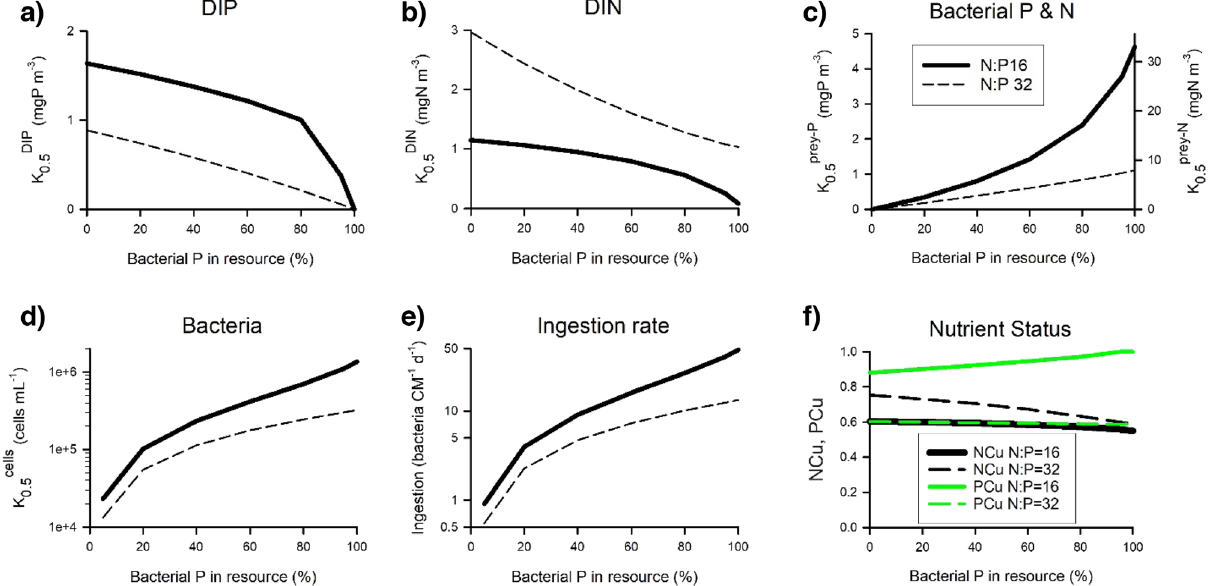
Figure 4. Relationships between the proportion of nutrients provided via phagotrophy and emergent half saturation values for resources supplied as inorganics (DIP, DIN) and/or as bacteria. These are outputs from the chemostat simulations run at a dilution rate to enable the constitutive mixoplankton (CM) to grow at half the maximum growth rate (i.e., as required to derive values of K 0.5 ). Data are shown for a CM of 5 µm ESD, growing with a total resource abundance of 70 mgN m −3 , associated with a total mole N:P of 16 or 32, with the indicated % of the P allocated as bacterial P (x-axis). K 0.5 values for DIP, DIN and bacteria are shown in panels ( a ), ( b ) and ( c ) respectively; the bacterial C:N:P was fixed, hence the same plot lines are read for K 0.5 prey-P and K 0.5 prey-N on different y-axes in ( c ). Panel ( d ) shows K 0.5 for bacteria cell numbers, with the ingestion rates in panel ( e ). Panel ( f ) shows the emergent N and P nutrient status of the mixoplankton, where 1 is replete and 0 is starved; only at resource N:P = 32 was P-status (PCu) lower than that for N (NCu). See Table S1 for stoichiometric values and Fig. S6 for the proportions of C, N and P acquired from in ingestion rates (Fig. 4e) reflect the interplay in photo-phago-physiology. Values for K 0.5 DIP (Fig. 4a), K 0.5 DIN (Fig. 4b), K 0.5 prey-P & K 0.5 prey-N (Fig. 4c), and, K 0.5 cells for prey (Fig. 4d) differed under resource regimes of N:P = 16 versus N:P = 32. P was more limiting than was N with N:P = 32, but this limitation was not so pronounced with higher allocations of resource P within bacteria (Fig. 4f). The proportion of P from bacteria that contributed to CM growth closely tracked the proportion supplied under both N:P resource regimes (Fig. S6). The contribution of prey biomass to mixoplankton needs was much lower for N than for P (< 50% of the P supply), and lower again in terms of C (< 20% of the P supply); these differences were greater for N:P = 32 (Fig. S6). The effect of growing mixoplankton at different photon flux densities (PFD) upon the balance of photo- versus phago- trophy is shown in Fig. 5 (cf. Fig. 4). The significance of feeding increased at lower PFD (provision of P from predation approached 100%), with significant contributions to growth at ingestions of even just a few bacteria per day for growth rates of around 0.2 d −1 . At lower PFD, ingestion rates were higher, supporting greater contributions of bacterial C,N,P to CM biomass. These higher ingestion rates at low PFD required higher prey abundances (Fig. S7). Concurrently, with the decline in the relative importance of phototrophy at those lower PFDs, higher residual DIP was present as more P was acquired via phagotrophy. Different N:P resource levels at different PFD also affected the N and P status of the mixoplankton (Fig. S8); the N:P = 32 series had a greater level of P-stress in the mixoplankton, but for both N:P scenarios, growth at lower PFD raised the N and P status because the cells became increasingly C-limited. The simulations shown in Figs. 4 and 5 used bacterial prey. Comparisons between rates of ingestion of bacteria or cyanobacteria required to support a given rate of CM growth in the N:P = 16 resource regime are shown in Fig. 6; at most these amounted to 1 ingestion per CM per hour to make significant contributions to growth rates of up to 0.6 d −1 . Contributions from feeding for the supply of C were low in all instances compared to contribu- tions of N and P, noting these simulations were undertaken in a light-saturating system with 20% of resource-P supplied as prey-P (cf. Fig. 5). Ingestion rates of only 1 to 6 prey d −1 supported 20% of P needs at growth rates of up to ca. 0.3 d −1 . The relative contributions from feeding declined at higher growth rates because encounter rates with prey became limiting relative to the increasing availability of inorganic nutrients (consistent with chemostat theory, and, also consistent with differences between the K 0.5DIN and K 0.5prey-N shown in Fig. 4). Prey abundances of the order of 10 4 mL −1 were required to support growth rates of < 0.1 d −1 , ranging up to ca. 5 × 10 5 mL −1 of the non-motile cyanobacteria prey (‘Cya’ in Fig. S9) to support a CM growth rate of 0.6 d −1 . Ingestion of cyanobacteria (‘Cya’ in Fig. 6) provided a less balanced nutrition (lower P:C, Table S1) than did ingestion of heterotrophic bacteria, requiring a higher ingestion rate from a higher prey abundance (Fig. S9, con- sistent with Fig. 3) to provide the most limiting element. A consequence was a higher contribution of ingestion to